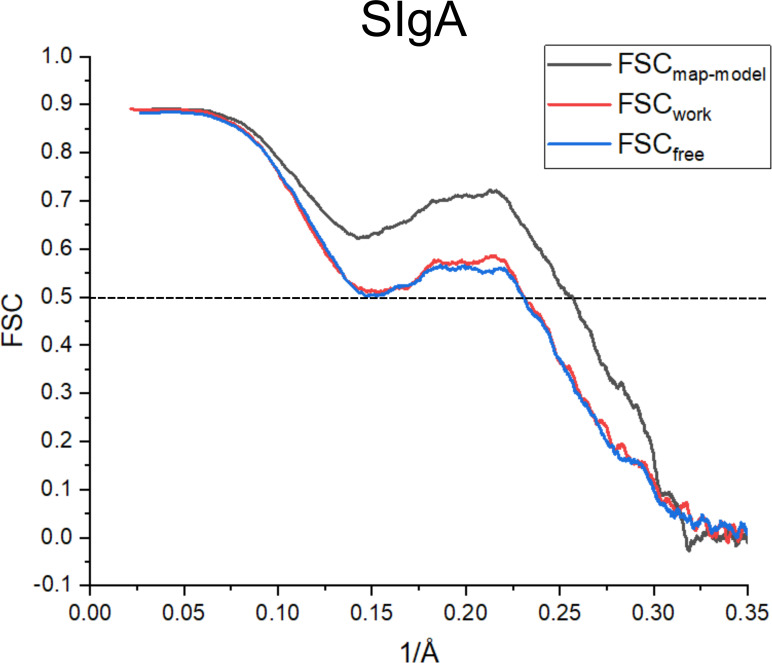
SIgA cross-validation FSC curves.The FSC curve generated between the final structure and CryoEM map including all data (FSCmap-model) is shown in black and indicates agreement between the map and final model. FSCwork (red) is the FSC curve generated between the final structure refined against half the data (half map 1) and half map 1. FSCfree (blue) is the FSC curve generated between the final structure refined against half map 1 and the other half of the data (half map 2), not used in refinement calculations. Close agreement between, FSCwork and FSCfree indicate that the model has not been overfit to the map.